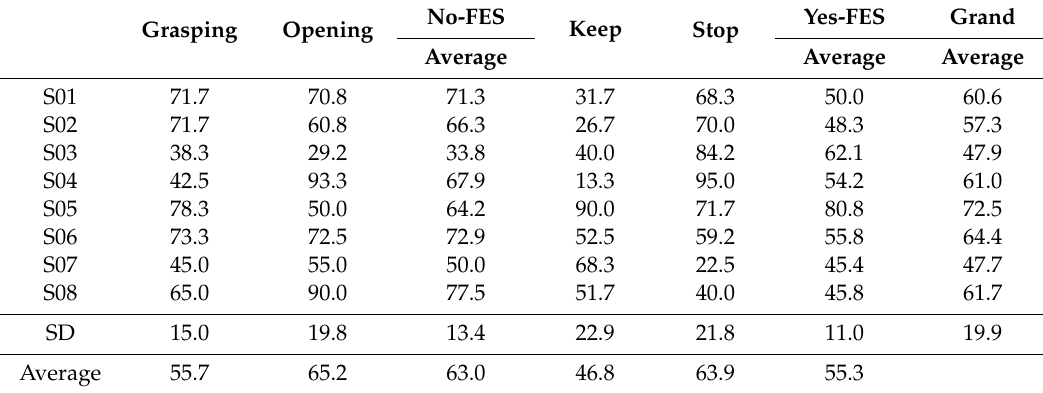
Table 2. Average completion rate for each task